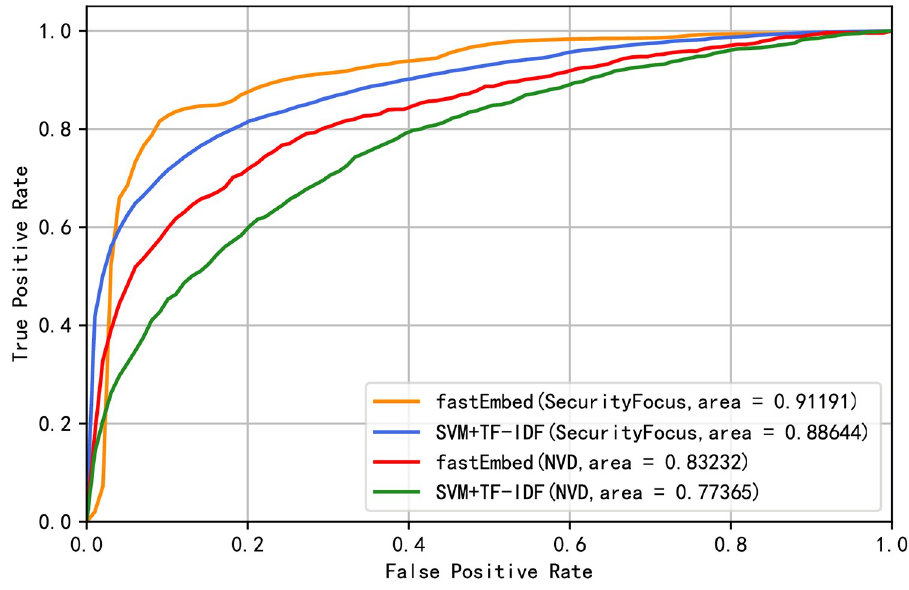
Fig 6. ROC curve of baseline model and